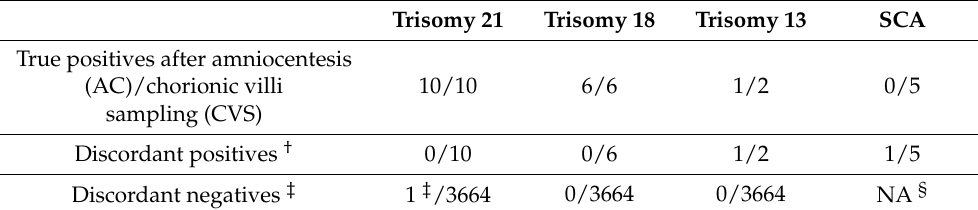
Table 4. Confirmation rate of NIPT results positive for common trisomies and sex chromosomal